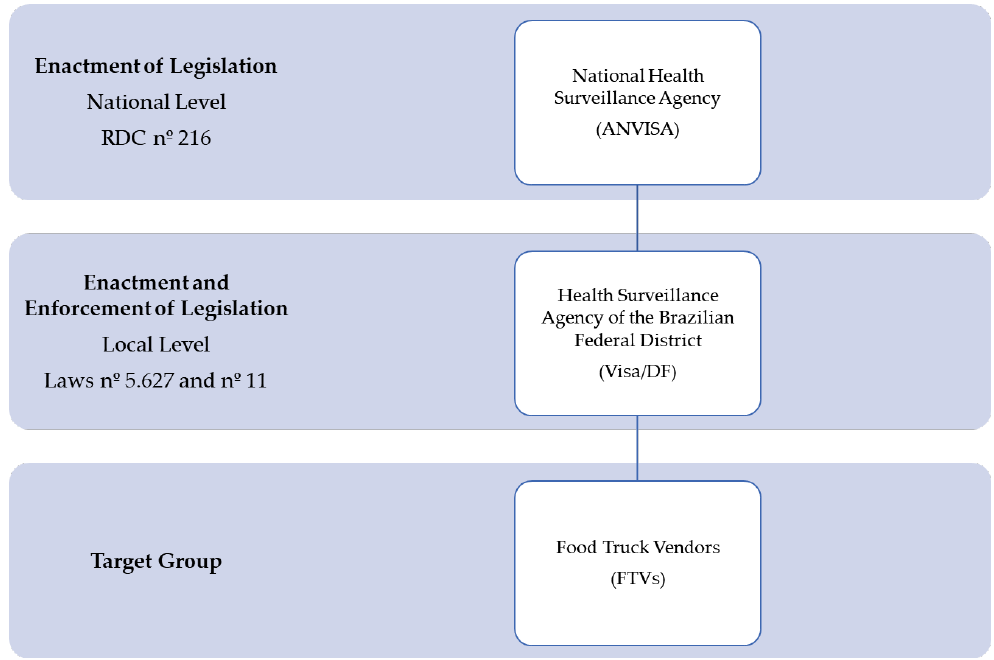
Figure 3. National and local legislation of food trucks in the Brazilian Federal District. Anvisa: Agência Nacional de Vigilância Sanitária (National Health Surveillance Agency); DF: Distrito Federal (Federal District); FTVs: food truck vendors.